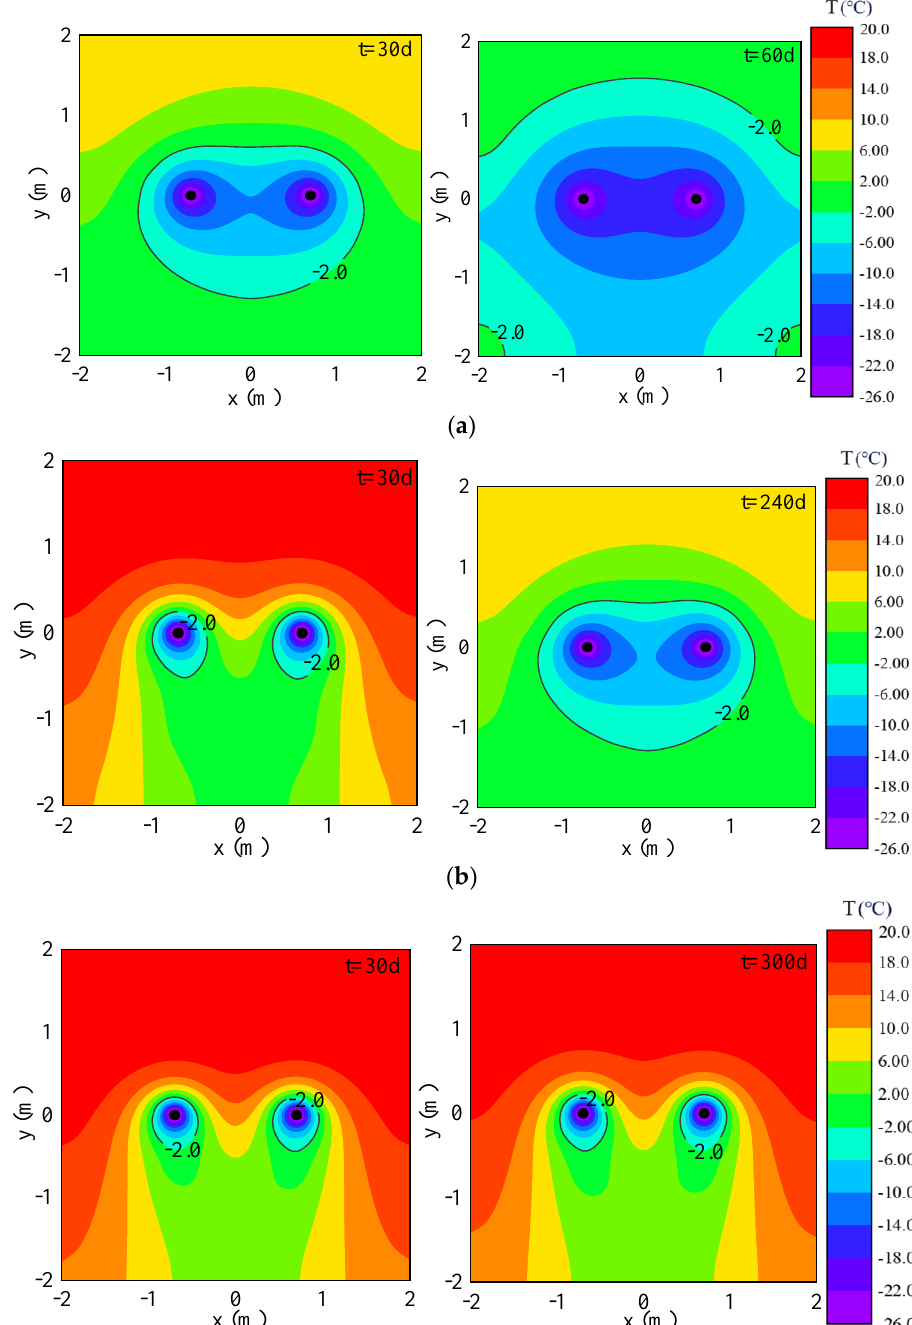
Figure 8. Interfacial temperature distribution developments of intact rock mass under different groundwater seepage velocities in the freezing process: ( a ) v = 1 m/d; ( b ) v = 1.5 m/d; ( c ) v = 2 m/d.